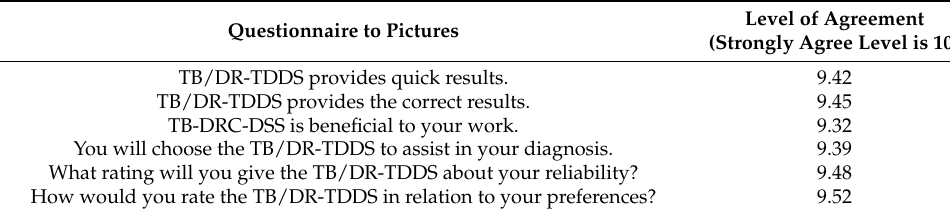
Level of Agreement (Strongly Agree Level is 10)